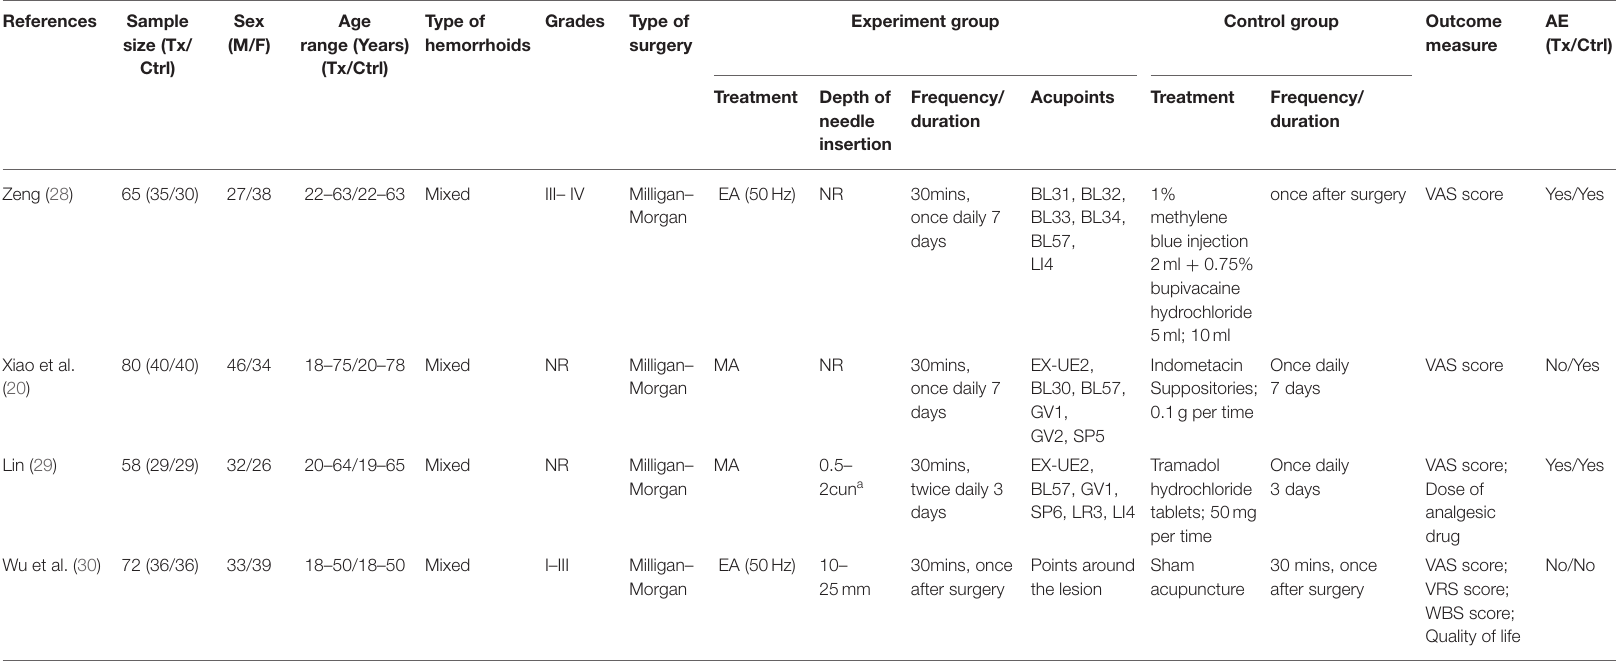
TABLE 1 | Characteristics of included randomized controlled trials